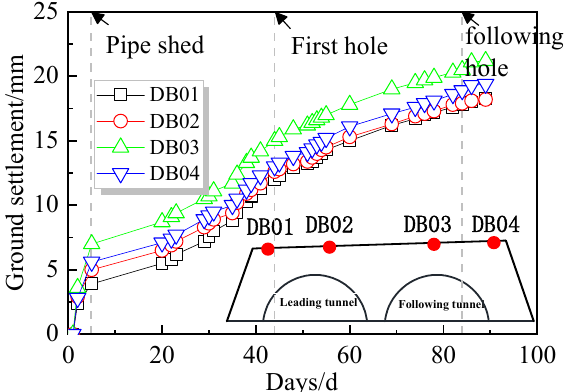
Figure 6. ZK0+710 surface subsidence time history graph.